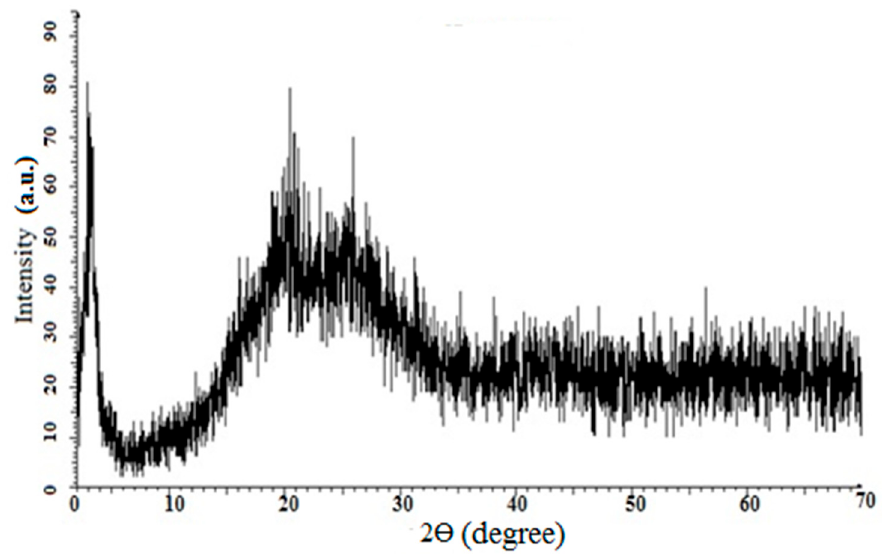
Figure 9. X-ray diffractogram of PANI salt.